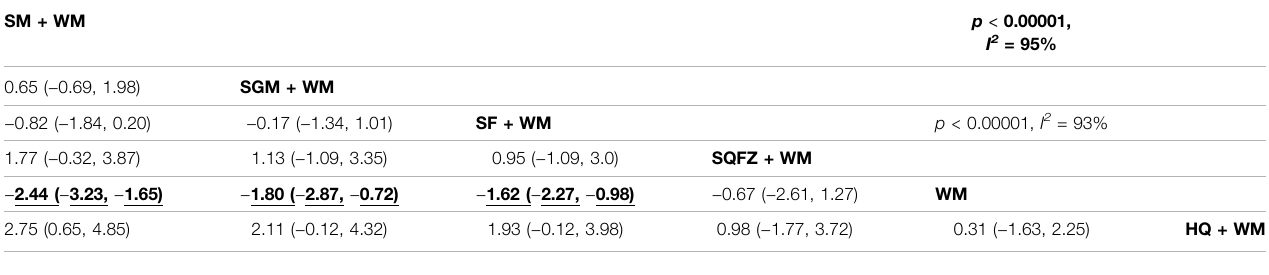
TABLE 4 | SMDs with 95% CIs of PCT. Signi fi cant effects are printed in bold.